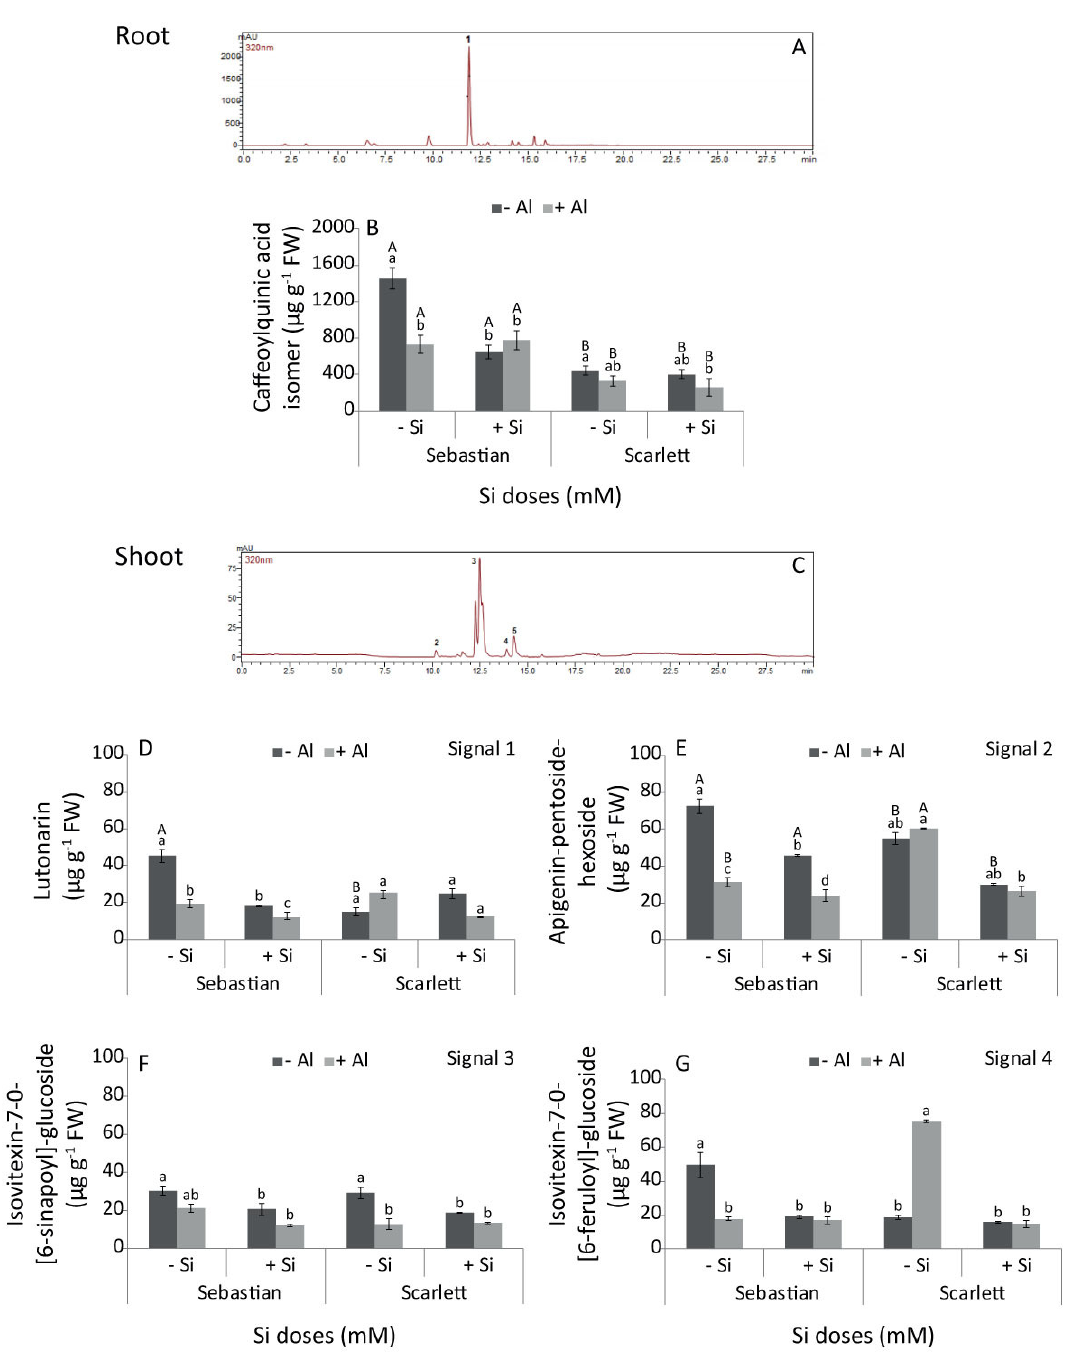
Figure 2. HPLC-DAD chromatograms ( A , C ) and individual phenolic concentration in shoots ( D – G ) and roots ( B ) of barley cultivars. Treatments were 0 or 0.2 mM Al, combined with 0 or 2 mM Si. Phenolic concentration values represent the mean of three replicates per treatment ± SD. Different letters indicate statistically significant differences ( p ≤ 0.05) among treatments. The lower case letters represent significant differences between treatments for the same barley cultivar. The upper case letters indicate significant differences between barley cultivars for the same treatment. When uppercase letters do not appear, no significant differences between the same treatment in different cultivars were found. Table 3. Identification of phenolics from barley extracts by using HPLC–DAD–ESI-MS/MS.